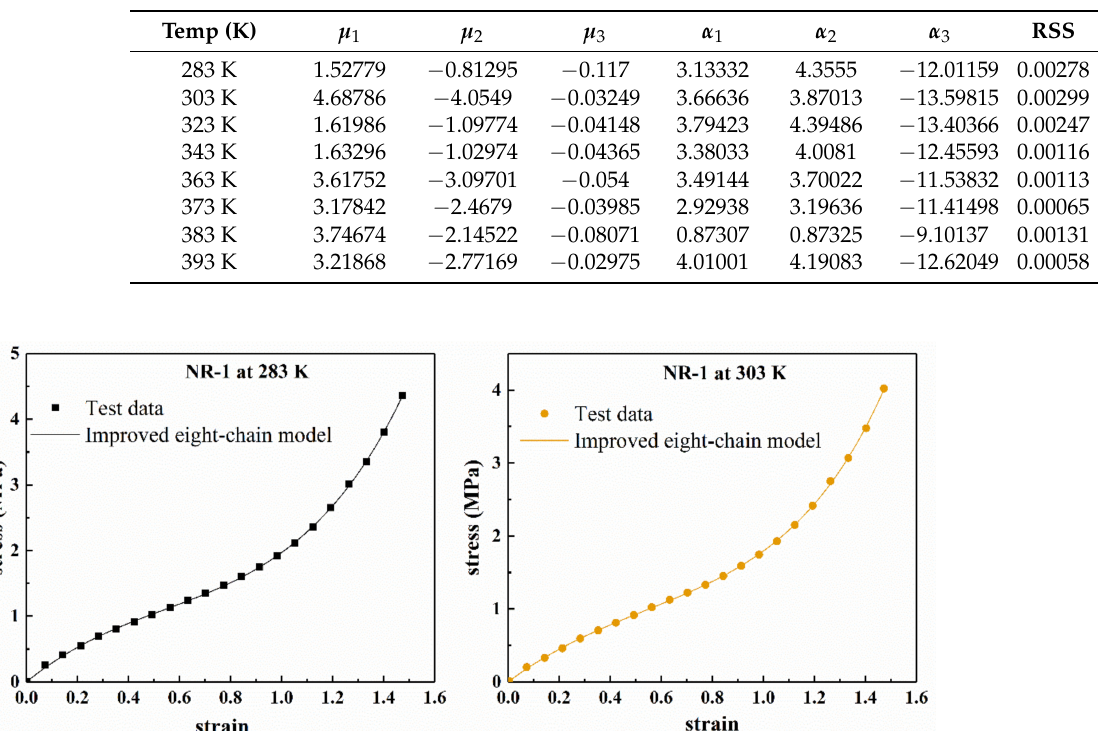
Figure 10. Trend of the Ogden model ( n = 3) parameters with temperature obtained by fitting the uniaxial tension data of filled rubber NR-1 at different temperatures. Table 4. Fitting parameters of Ogden model ( n = 3) to test data of filling rubber NR-1 at different tem- peratures.